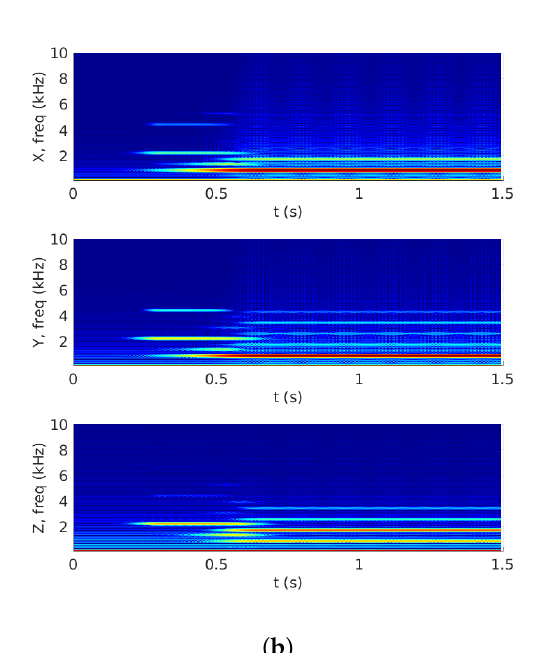
Figure 2. Transient nonlinear behavior of the system for µ = 0.8 ( a ) time responses and ( b )